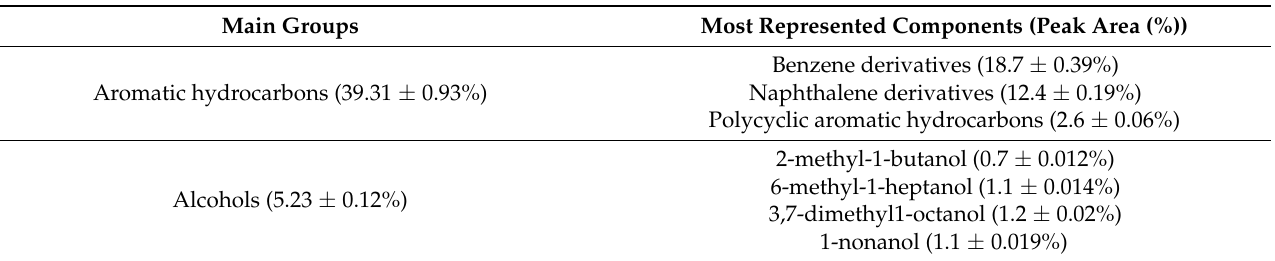
Table 2. Cont. Main